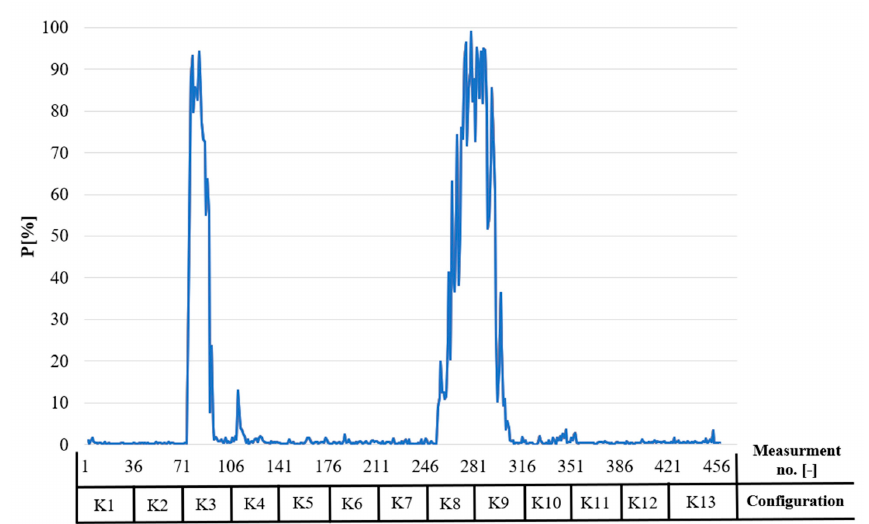
Figure 8. The number of data packets lost in each of the tests carried out.